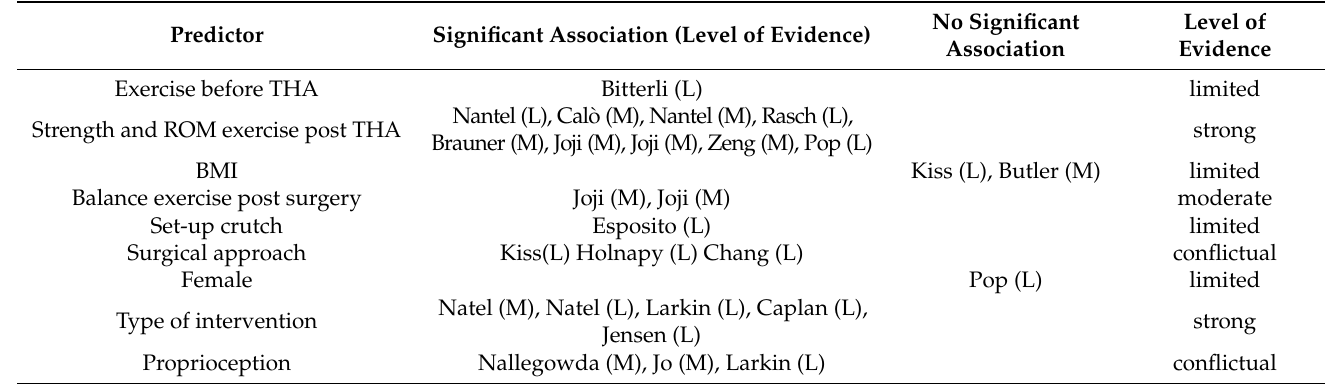
Table 1. Treatment-related changes.